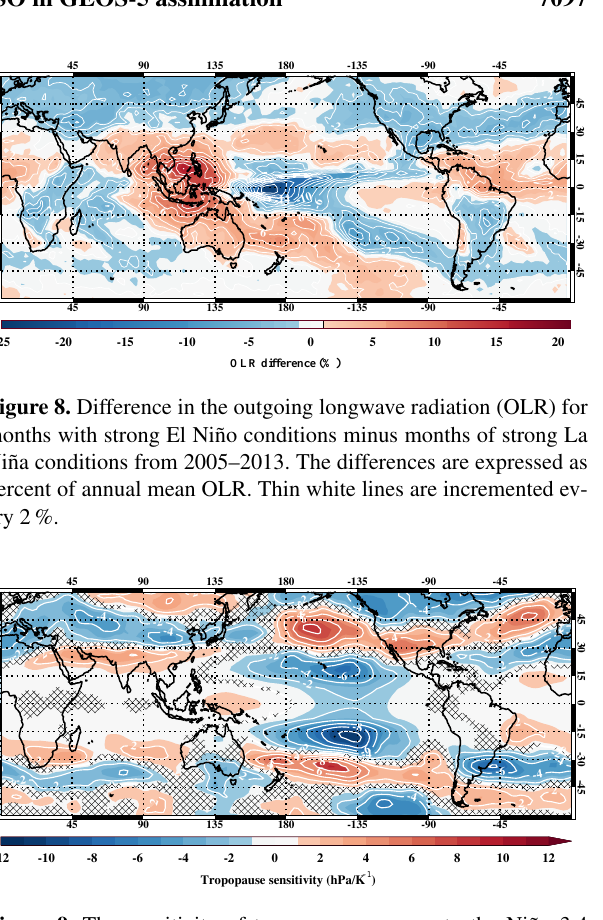
dencies (red line) and dynamical tendencies (black line) be- tween 180 and 120 ◦ W. In the tropics, the convective ten- dency differences range from − 0.15 to 0.1 DU day − 1 . The dynamical tendency differences are negative and the magni- tudes are more than twice as great as the convective tendency differences. In the middle latitude north Pacific between 40 and 50 ◦ N, the magnitude of the El Niño–La Niña